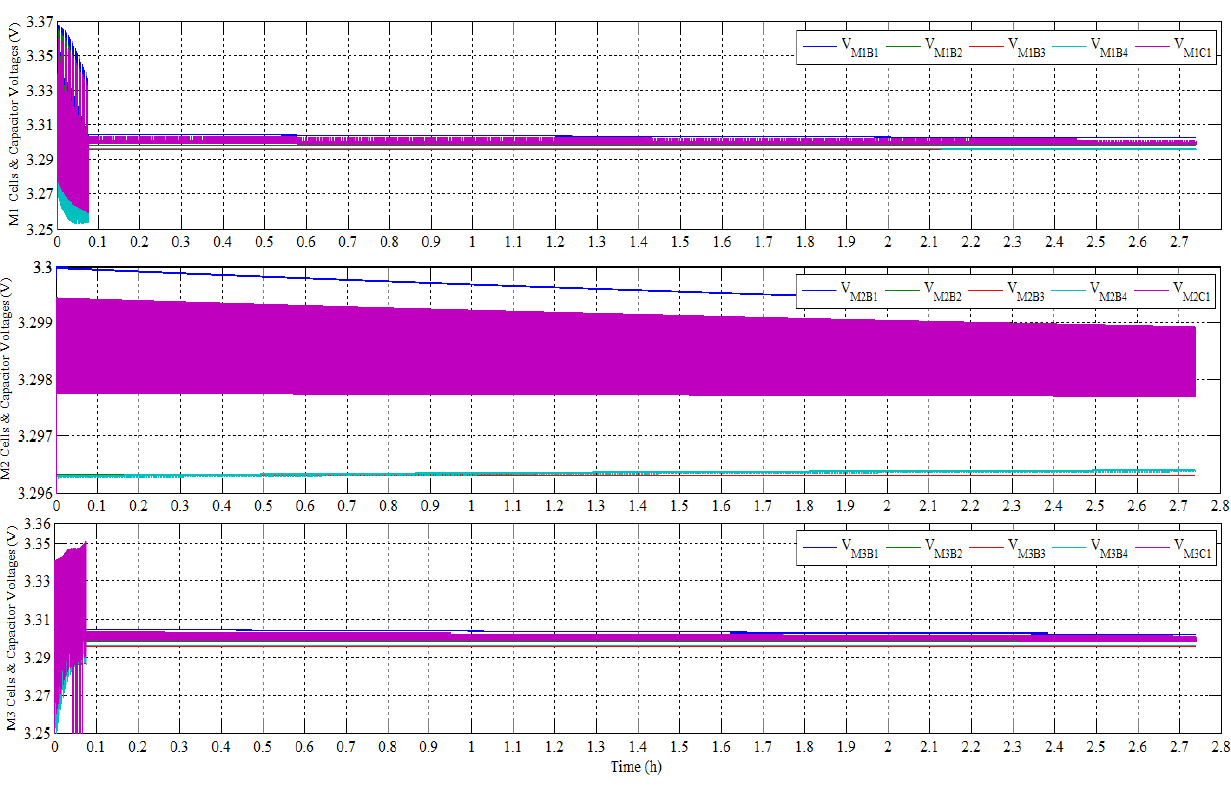
Figure 11. Simulation No. 2 (proposed SSCs and BC) results: Module 1 cells voltages, Module 2 cells voltages and Module 3 cells voltages.